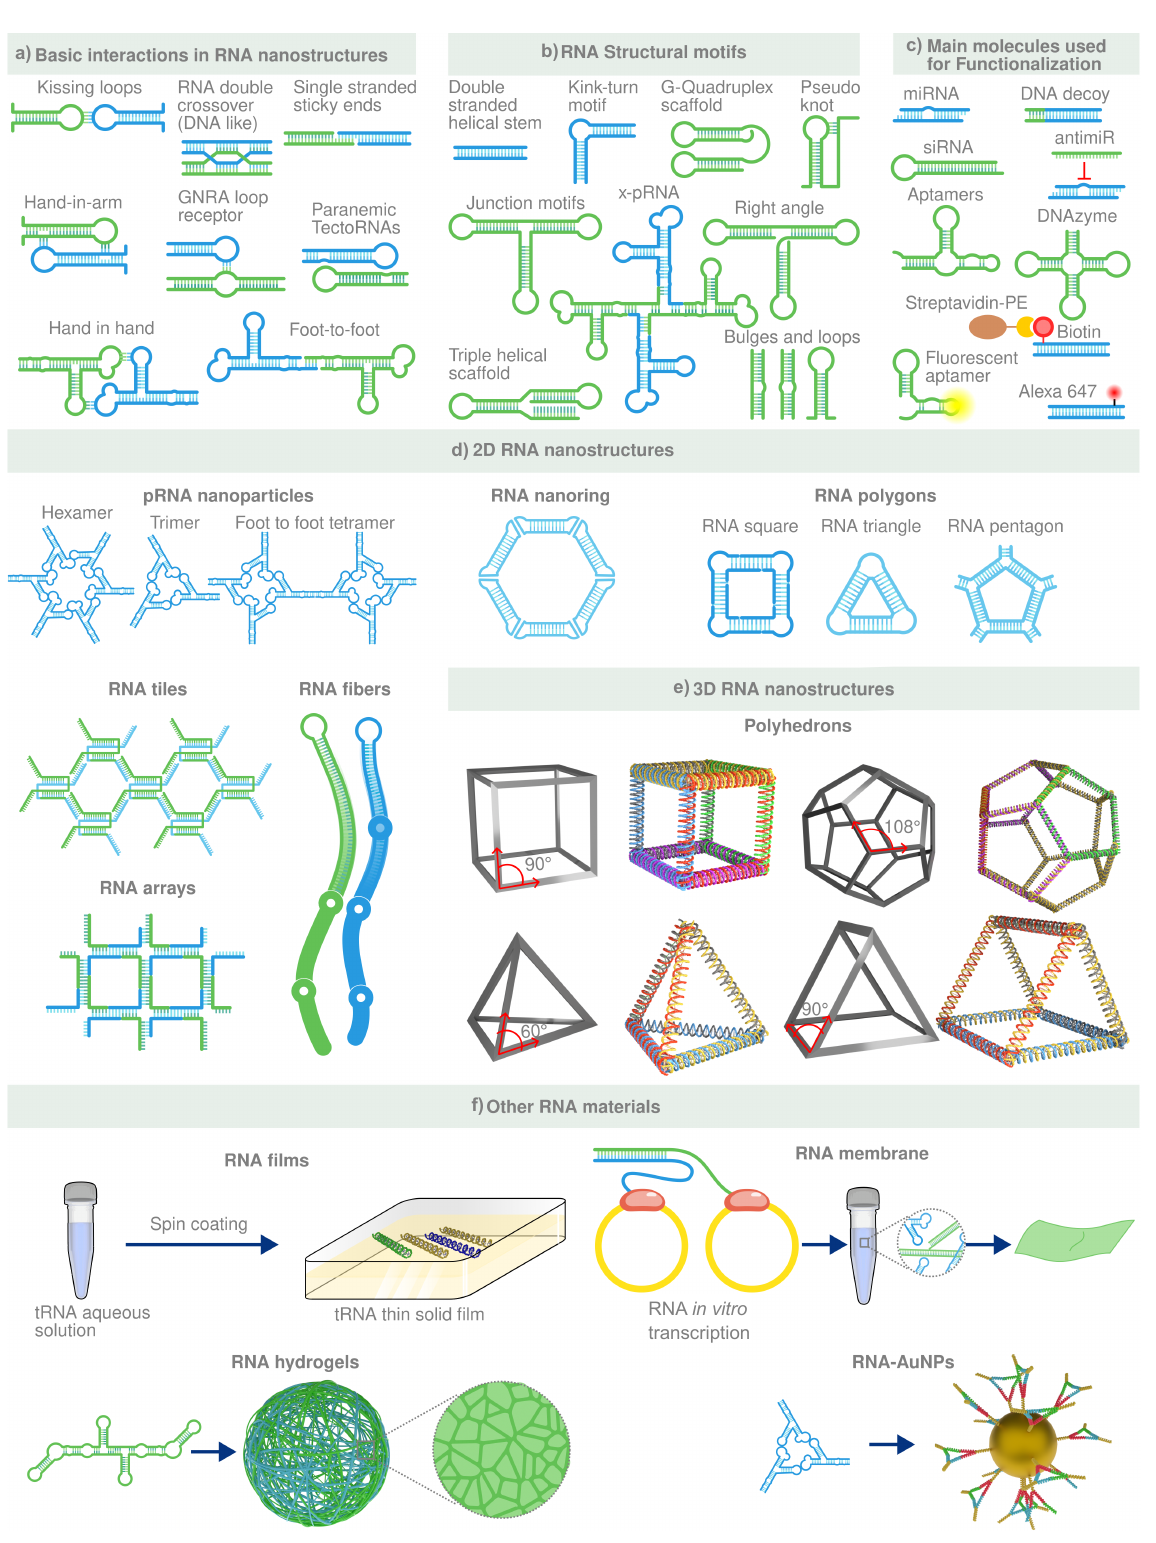
Figure 6. Main aspect of RNA and the construction of nanostructures. ( a ) Basic interactions be- tween RNA motifs that are relevant for the assembly of RNA nanostructures. ( b ) Main RNA struc- tural motifs. ( c ) Examples of molecules that are used for functionalization of RNA nanostructures. ( d ) Examples of 2D RNA nanostructures. ( e ) Main 3D RNA nanostructures. ( f ) Different kind of materials that have been created with